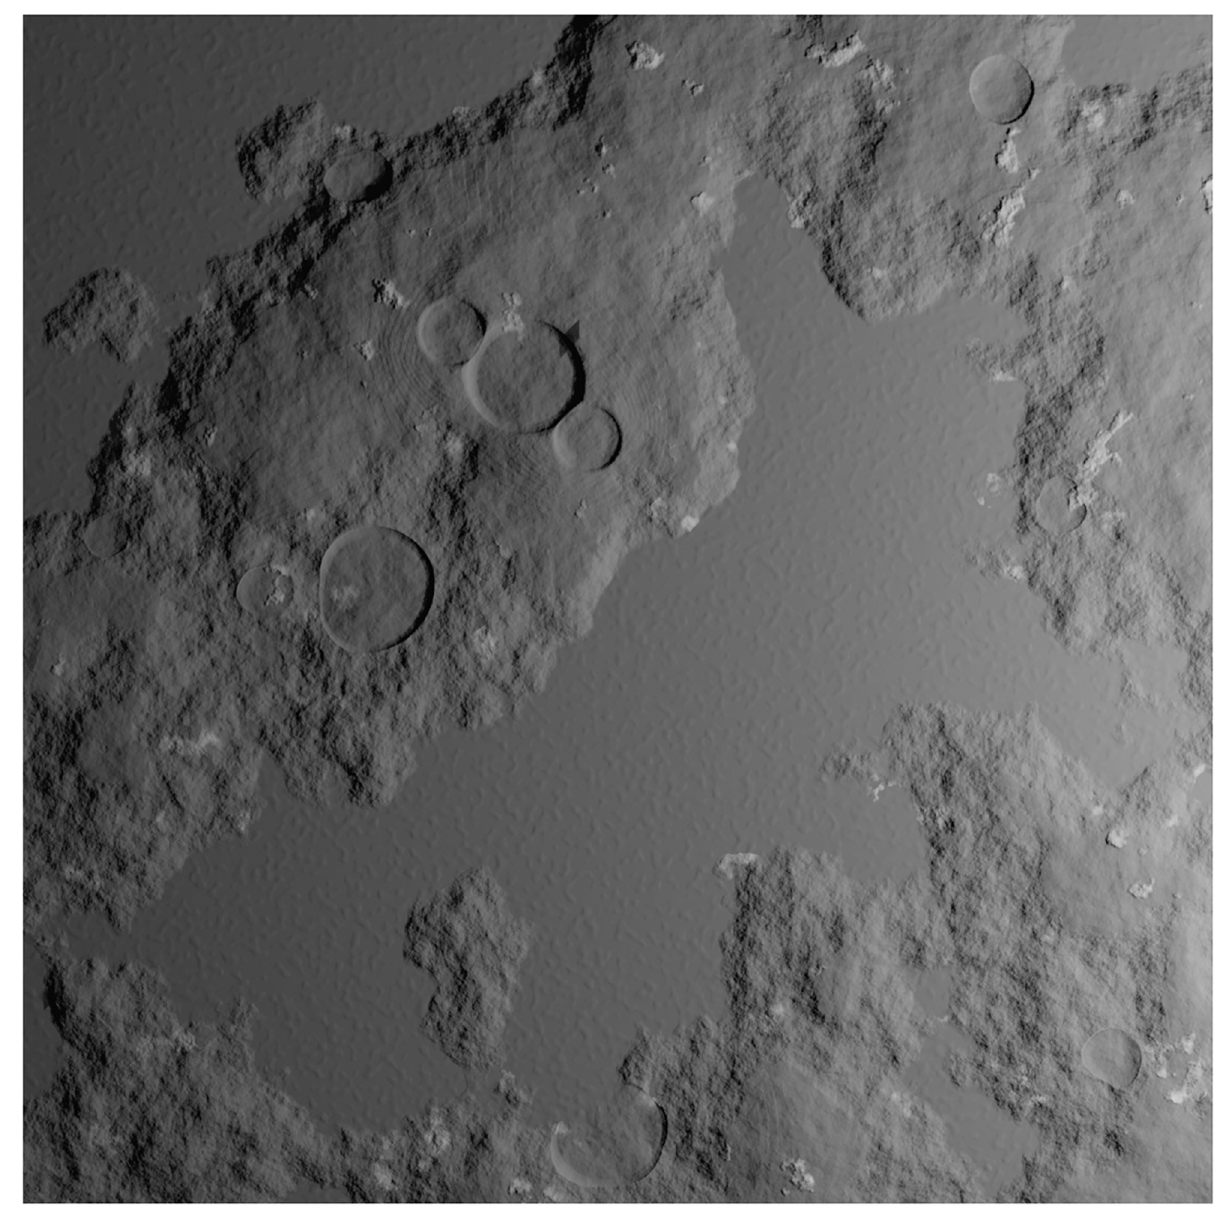
Fig 4. Final procedural shader applied to a subdivided